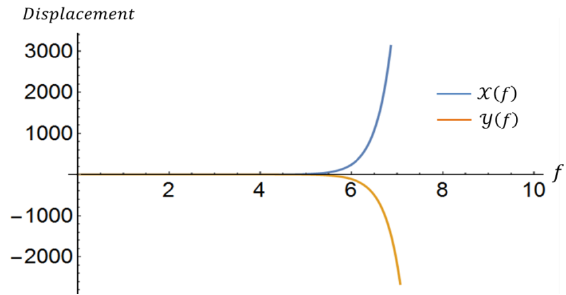
Figure 2. The growth of a small displacement for a test particle placed at L 1 vs. f